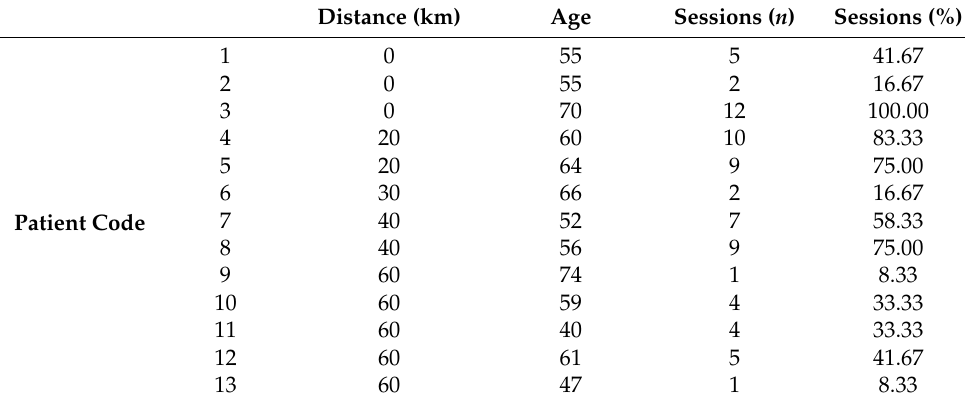
Table 1. Characteristics of the patients (age/distance).